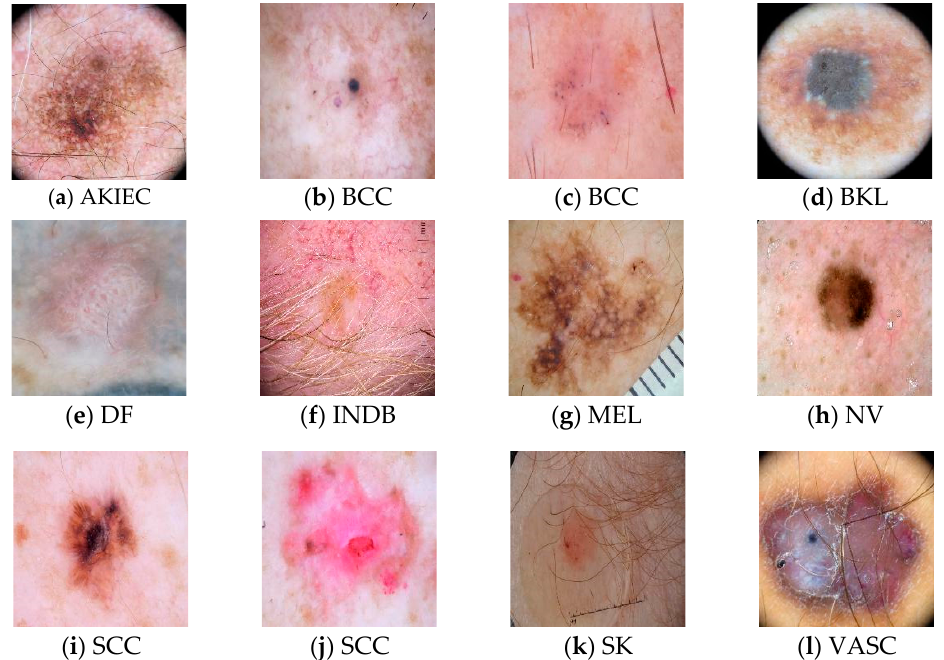
Figure 2. Samples of Skin Lesion Images. Table 2. Experimental datasets for training and